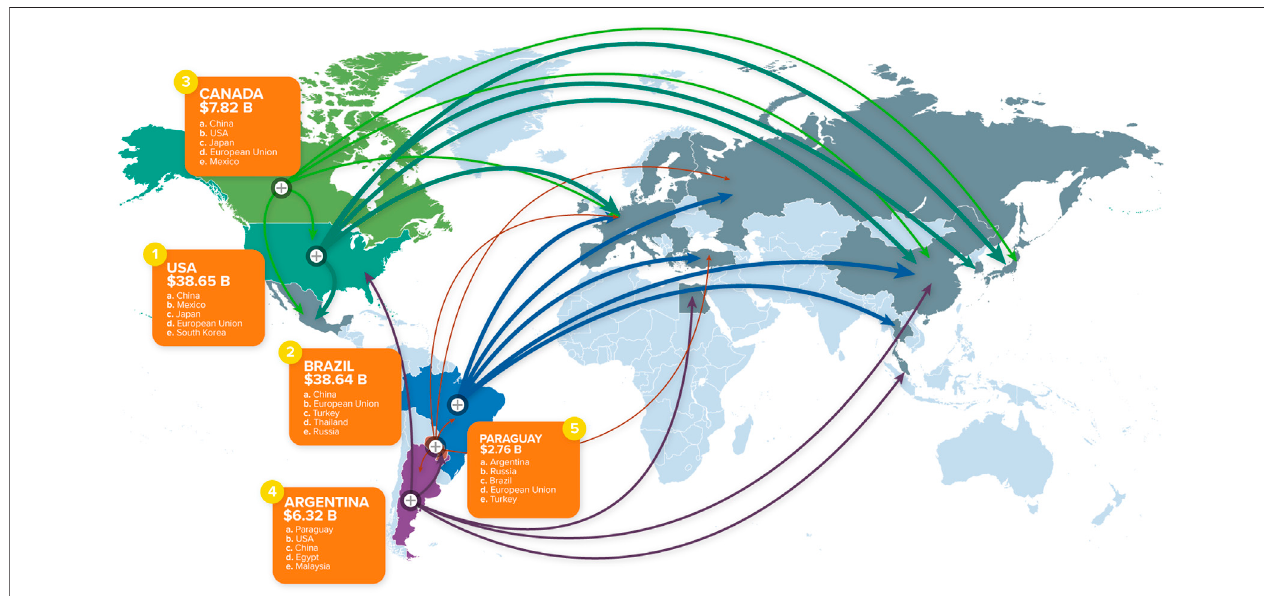
FIGURE1| Worldmapshowingthetop fi veproducersoftransgeniccropsandtheirmajortradingpartners,compiledbyCropLifeInternationalbasedon2018data (source: https://croplife.org/news/global-agriculture-a-trade-map/). More information for each of the top fi ve countries is available at the CropLife International website. Approval was obtained from CropLife International to use the image in Figure 1